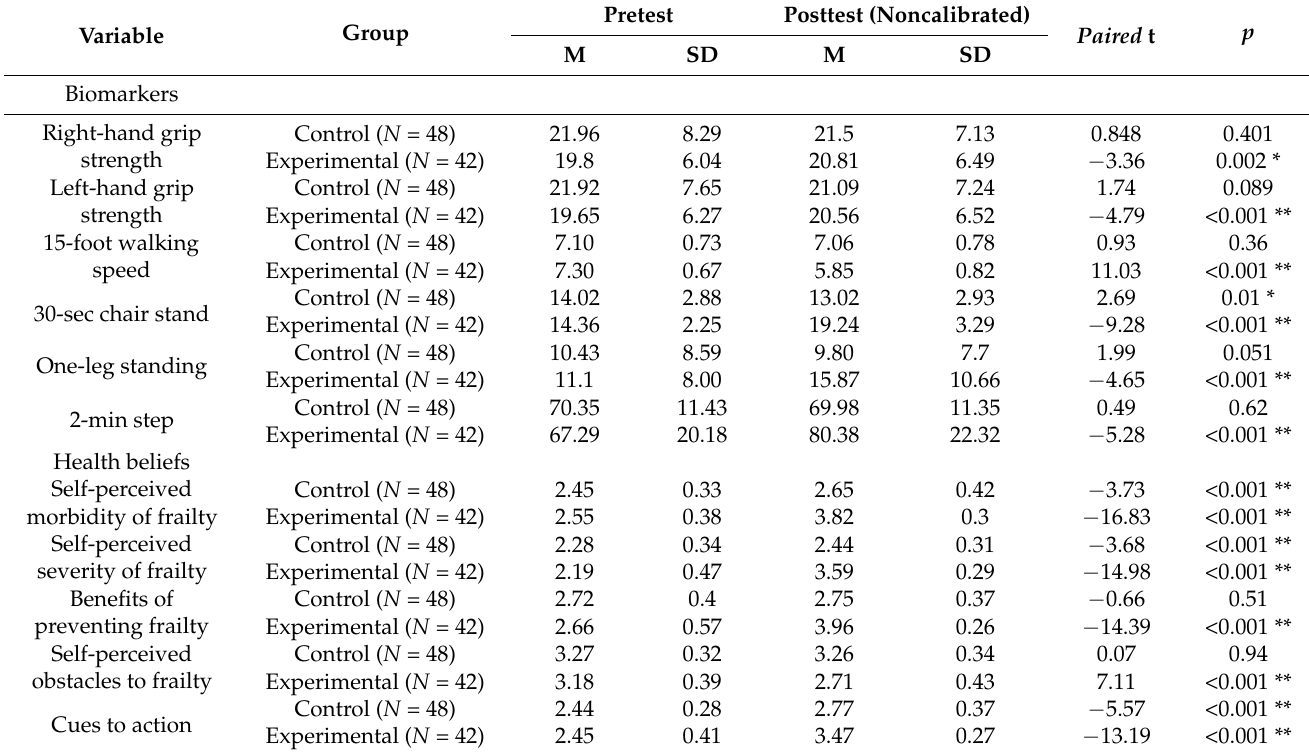
Table 3. Pre-test and post-test results of the experimental and control groups for biomarkers and health beliefs.